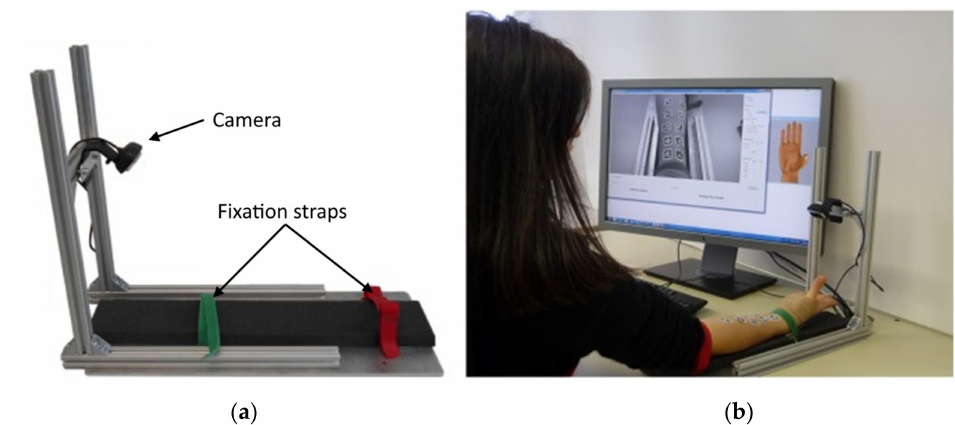
Figure 8. Optical myography experimental setup [126]. ( a )—rig for stable fixation of the user’s hand. ( b )—example of data acquisition during the experiment, visual fiducial markers are placed on the ventral side of the user’s forearm. Adapted from [126], licensed under CC BY